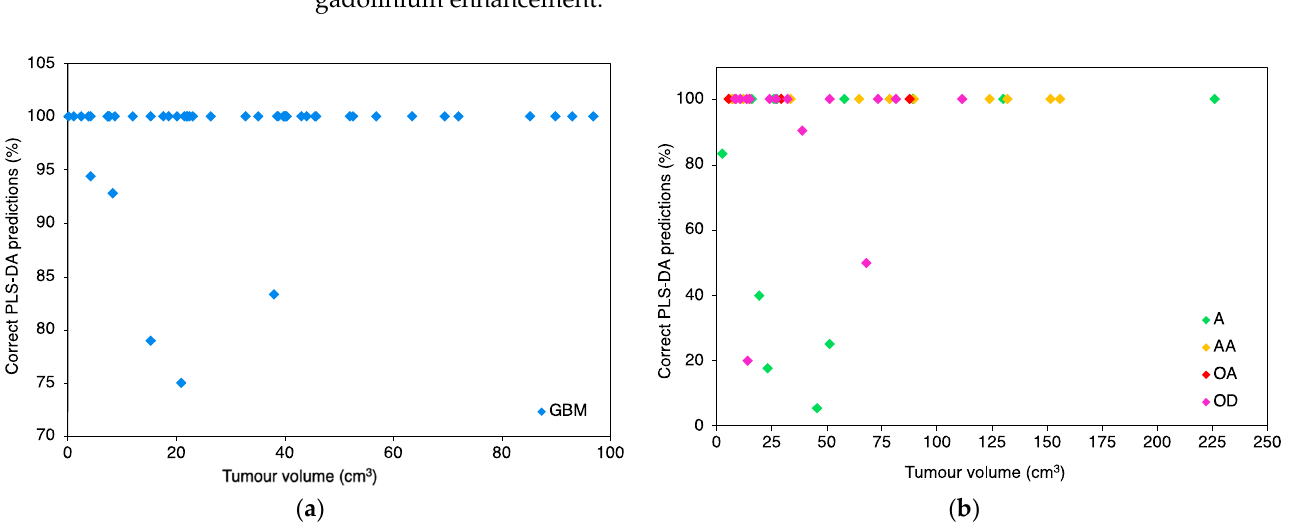
Figure 1. Percentage of correct cancer predictions for every patient over nine repeats and 51 iterations with the partial least squares-discriminant analysis (PLS-DA) classification model. T1 cohort ( a ) and T2/FLAIR cohort ( b ).